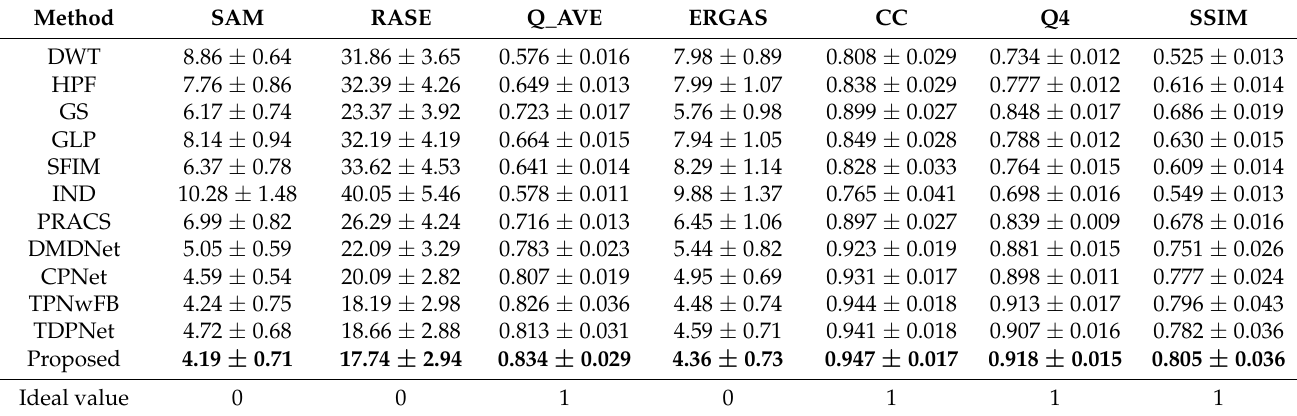
Table 4. Evaluation results on the WorldView-2 dataset (best results in